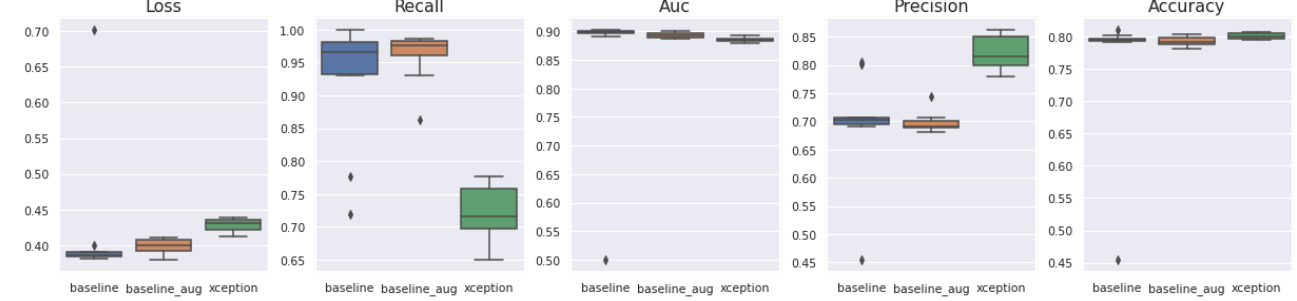
Figure 14. Classification results of the proposed ShuffleNet-Light, when Xception-v3 is deployed as a pretrained model without data augmentation techniques.